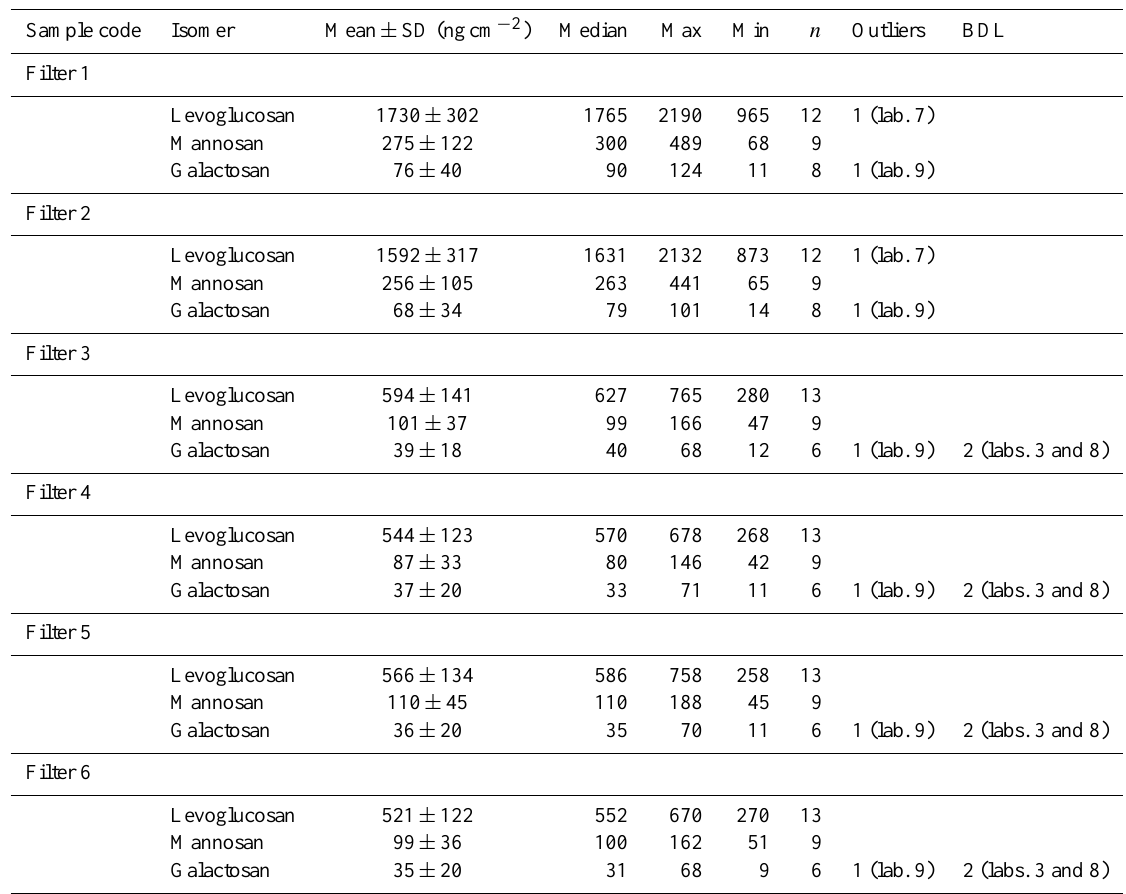
Table B3. Calculated mean ( ± SD) and median concentrations as well as maximum and minimum concentrations of levoglucosan, mannosan and galactosan in the six filter samples subjected to the intercomparison, as obtained by the various methods applied. Number of values included in the calculated concentrations, outliers and values below the detection limit (BDL) are listed. Outliers and values BDL are not included in the calculated concentrations, nor in the listed maximum and minimum